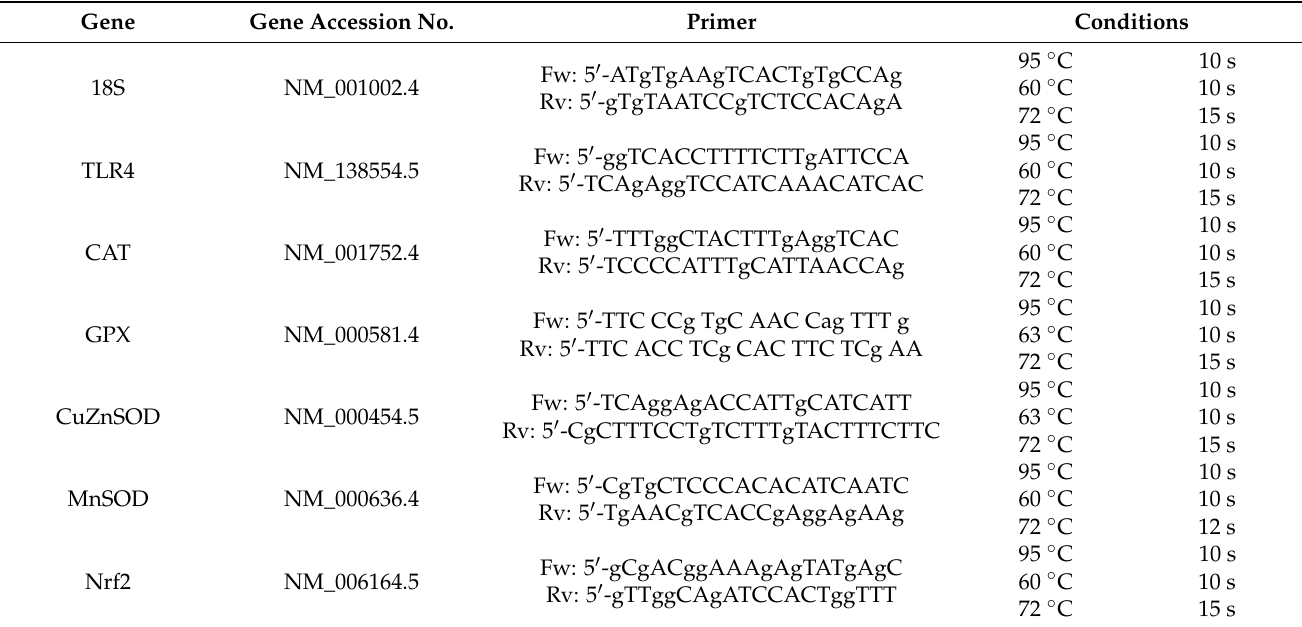
Table 1. Primer sequence and conditions used in Real-Time